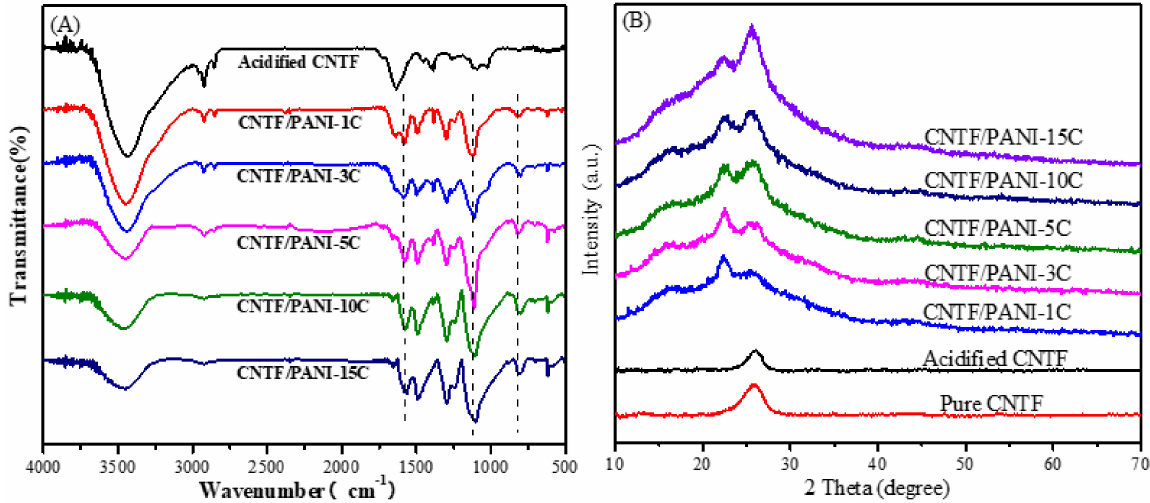
Figure 5. ( A ) FTIR spectra of acidified CNTF, CNTF/PANI-1C nanocomposites,